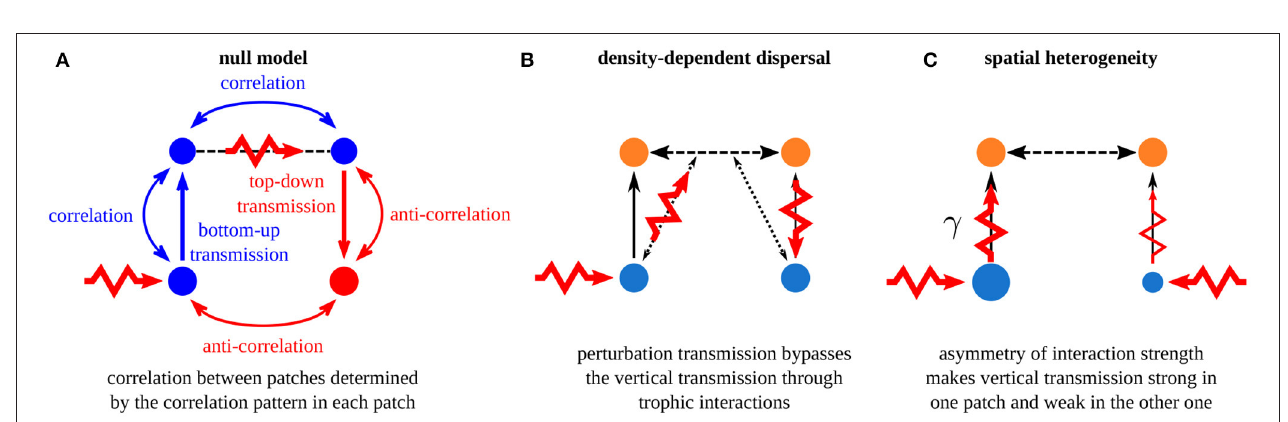
FIGURE 12 | Crossed effects of density-dependent dispersal and asymmetry of interaction strength γ when carnivores are perturbed (A) in patch #1 or (B) in patch #2. Synchrony is explained by the successive steps of perturbation propagation across the metacommunity. 1 Direct stochastic perturbation of carnivores in one patch. 2 Horizontal transmission to the other patch by density-dependent dispersal that bypasses vertical transmission in the perturbed patch. 3 Vertical transmission in the other patch through trophic interactions. This vertical transmission is stronger in patch #1 than in patch #2 because of the high biomasses (disc size) and the interaction strength, which is γ times higher in patch #1 than in patch #2, which leads to strong trophic interactions (arrow size).